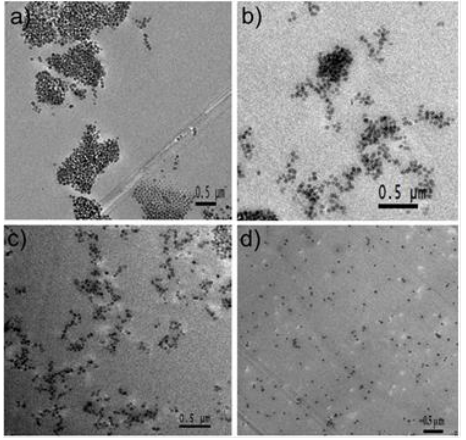
Figure 5. Representative TEM-images of ultramicrotome-cuts (100–300 nm thickness) of 5 wt% larger SiO 2 nanoparticle in epoxy resins. ( a ) 5% larger SiO 2 unmodified, ( b ) 5% DEG-TMeOs@SiO 2 , ( c ) 5% Diol-TMeOs@SiO 2 , ( d ) 5% Gly-TMeOs@SiO 2 . Image ( b ) was reproduced with permission of John Wiley & Sons Ltd. from a previous publication for reasons of comparison [24]. Table 3. Hard sphere volume fraction values η for different percentages of surface modified SiO 2 and ZrO 2 nanoparticles in epoxy resin matrix.